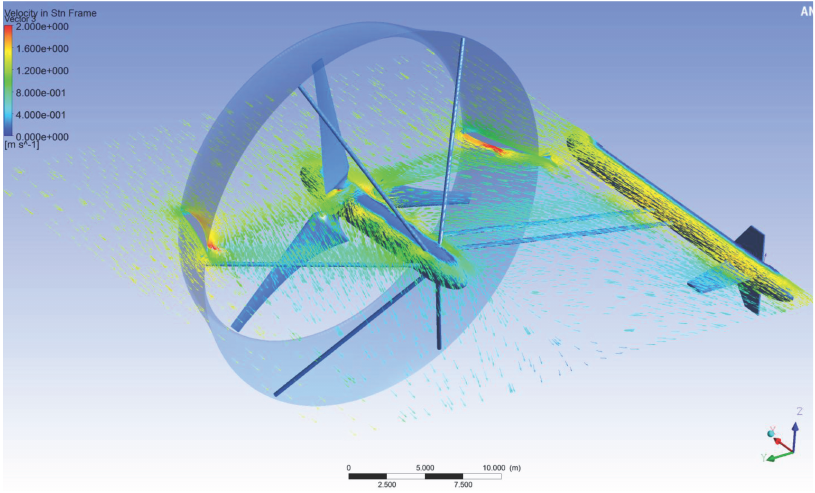
Figure 7. Flow field around the